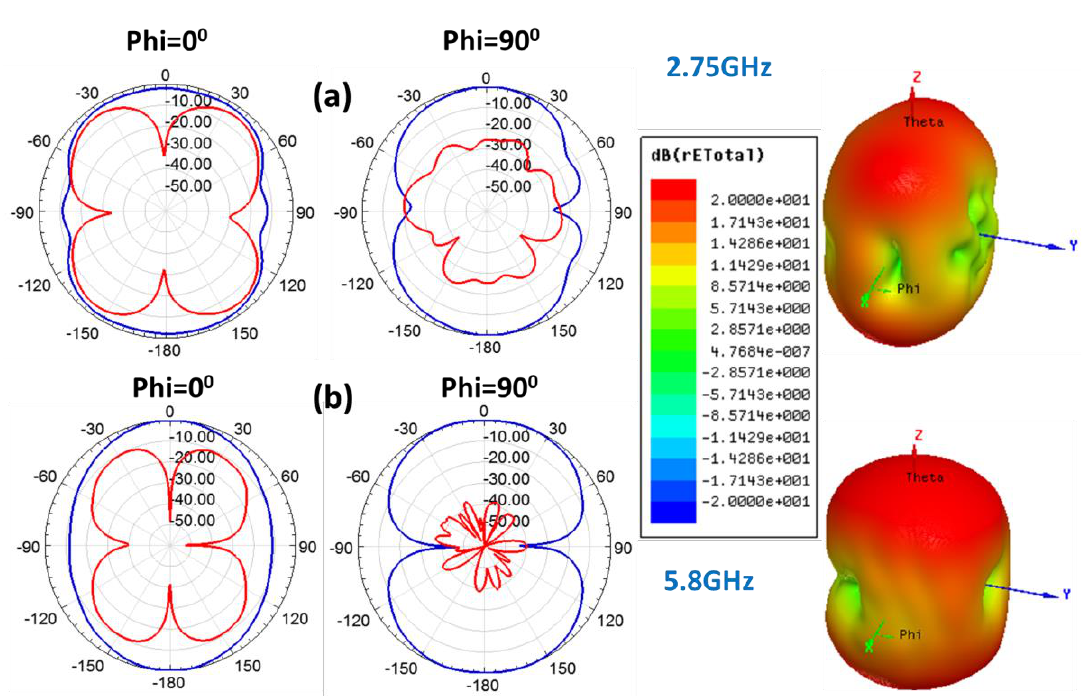
Figure 5. Radiation patterns obtained in simulation for the CPW-fed monopole antenna on ENrG’s Thin E-Strate respectively at 2.75 GHz ( a ) and 5.8 GHz ( b ). The blue traces stand for co-polarization (CP) and the red ones for cross-polarization (XP).